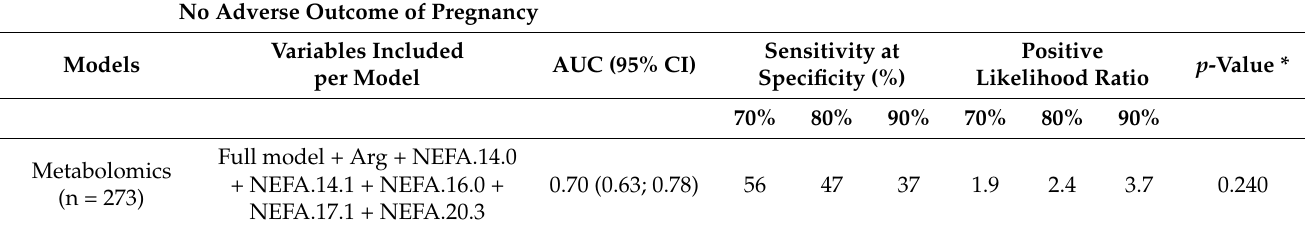
Table 4. Selection and performance of maternal